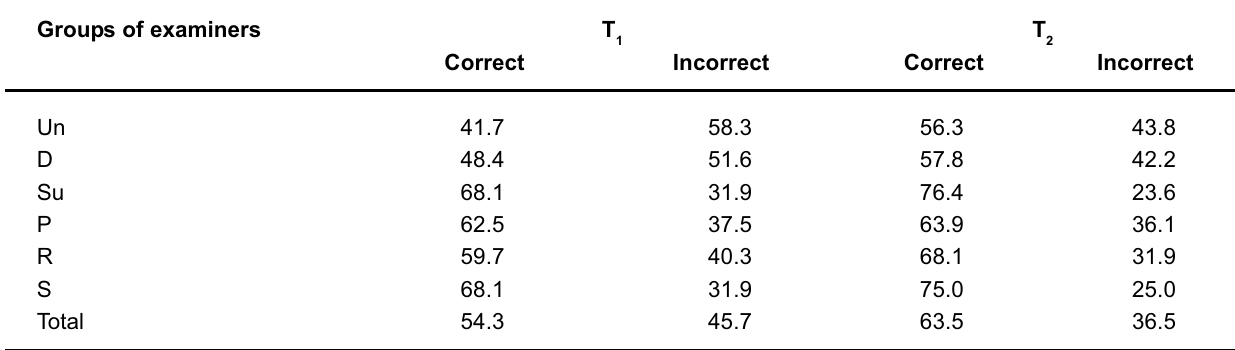
TABLE 1- Rates (%) of correct and incorrect answers before (T to distinct groups of